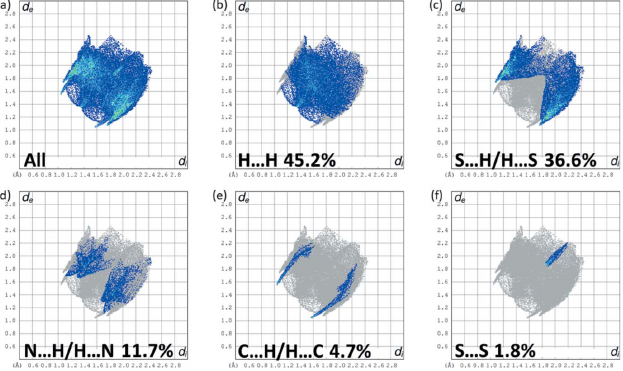
Figure 11 ( a ) The Hirshfeld surface of L1 , mapped over d norm in the colour range 0.0058 to 0.9525 a.u. and ( b ) the Hirshfeld surface of compound L2 , mapped over d norm in the colour range (cid:4) 0.1279 to 1.1192 a.u..